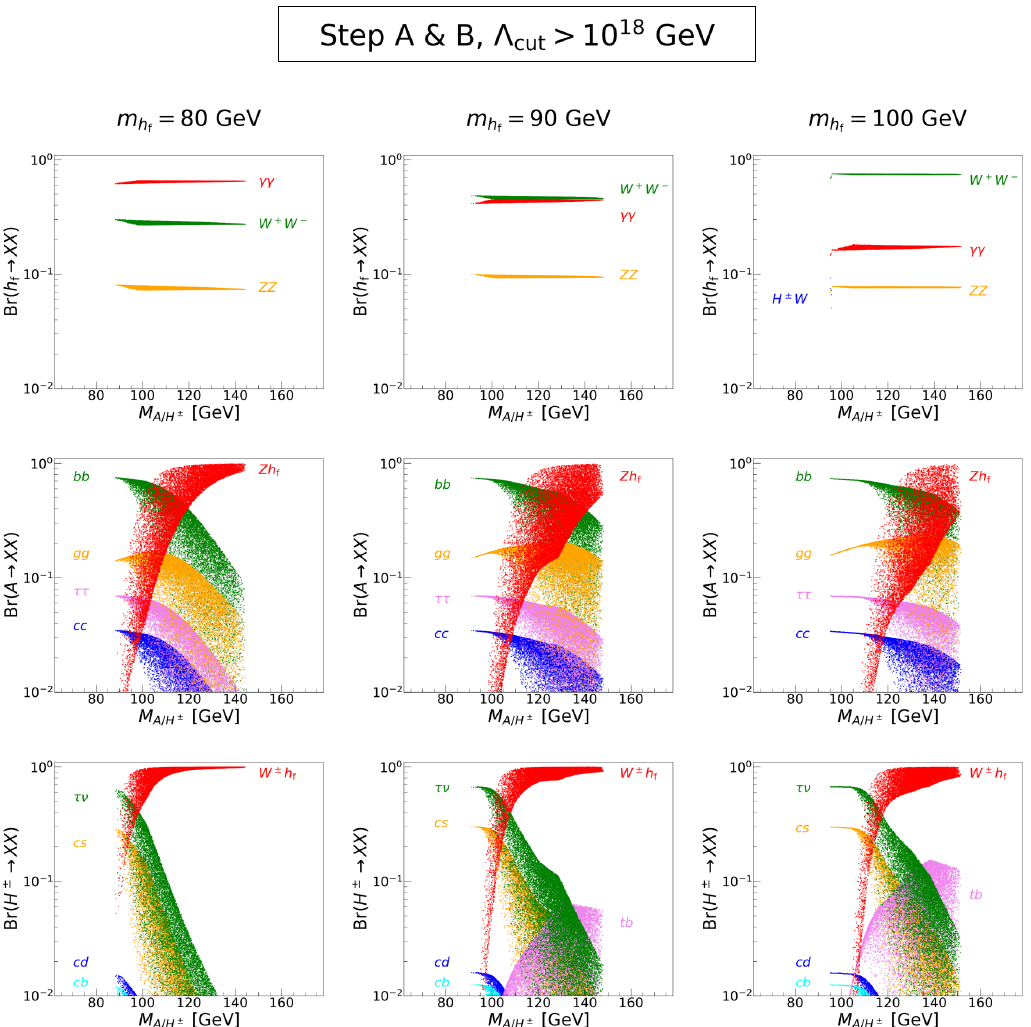
Figure 3 . Branching ratios of h f (upper panels), A (middle panels), and H ± (lower panels) for the viable parameter points with Λ cut > 10 18 GeV . The results of m h m h = 100 GeV are in the left, middle, and right panels, f